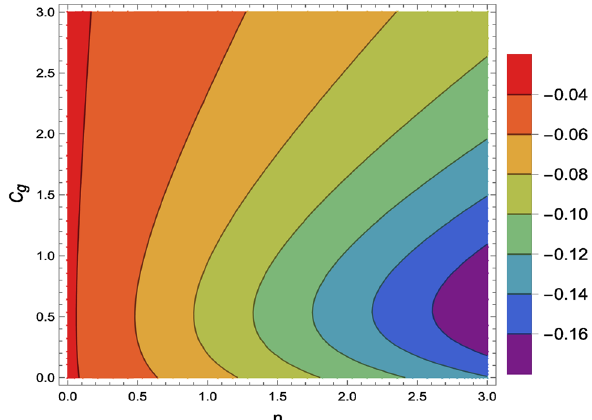
Figure 30. C g due to n .